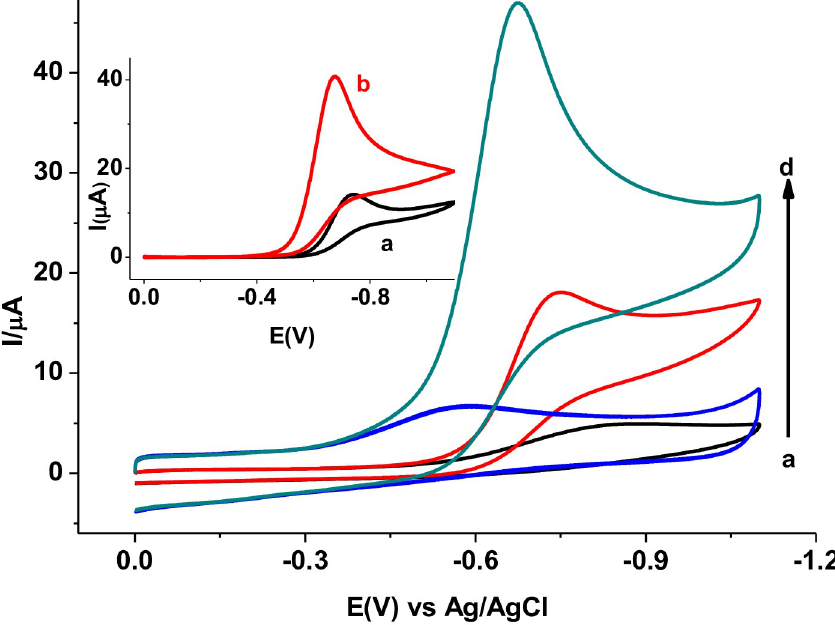
Fig 4. Cyclic voltammograms of bare GCE (a & c) and PARS/GCE (b & d) in the absence (a & b) and presence (c & d) of 1.0 mM MTZ in pH 7.0 PBS at scan rate 100 mV s -1 . Inset: corrected for blank cyclic voltammograms of bare (a) and PARS/GCE